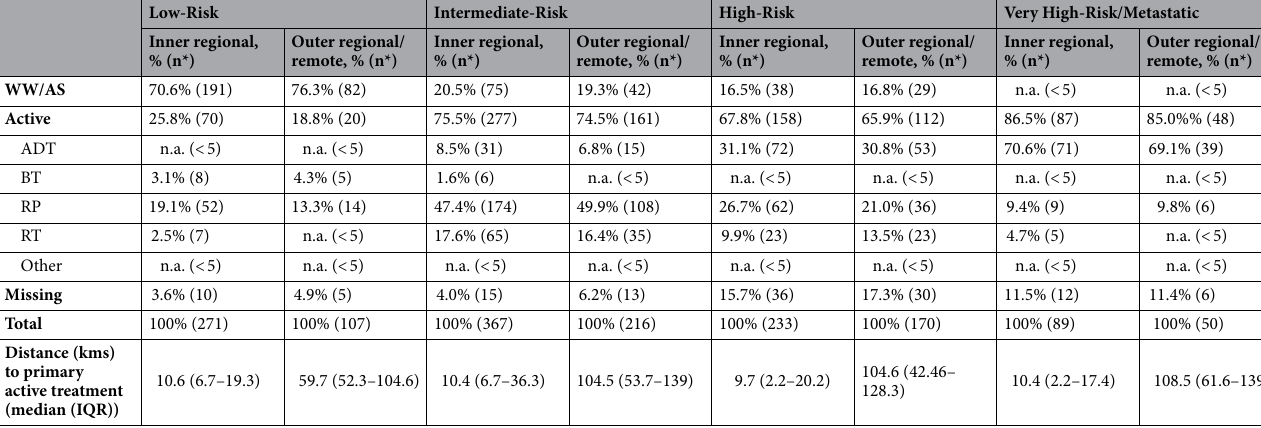
Table 3. Treatment approaches and distance to treatment, stratified by NCCN risk, of men with prostate cancer in inner and outer regional/remote areas of Tasmania. NCCN = National Comprehensive Cancer Network; WW/AS = Watchful Waiting/Active Surveillance; n.a. = Not Applicable; ADT = Androgen Deprivation Therapy; BT = Brachytherapy; RP = Radical Prostatectomy; RT = Radiotherapy; kms = kilometers; IQR = Interquartile Range. *All analyses are weighted for remoteness classification (see “Methods”). Subject numbers are rounded to the nearest integer value.